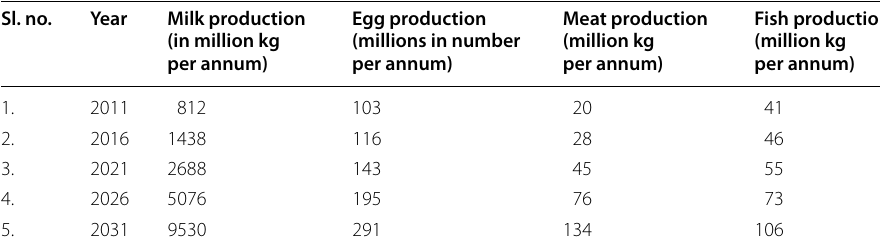
Table 12 Projected production of milk, egg, fish, and meat Sl. no.